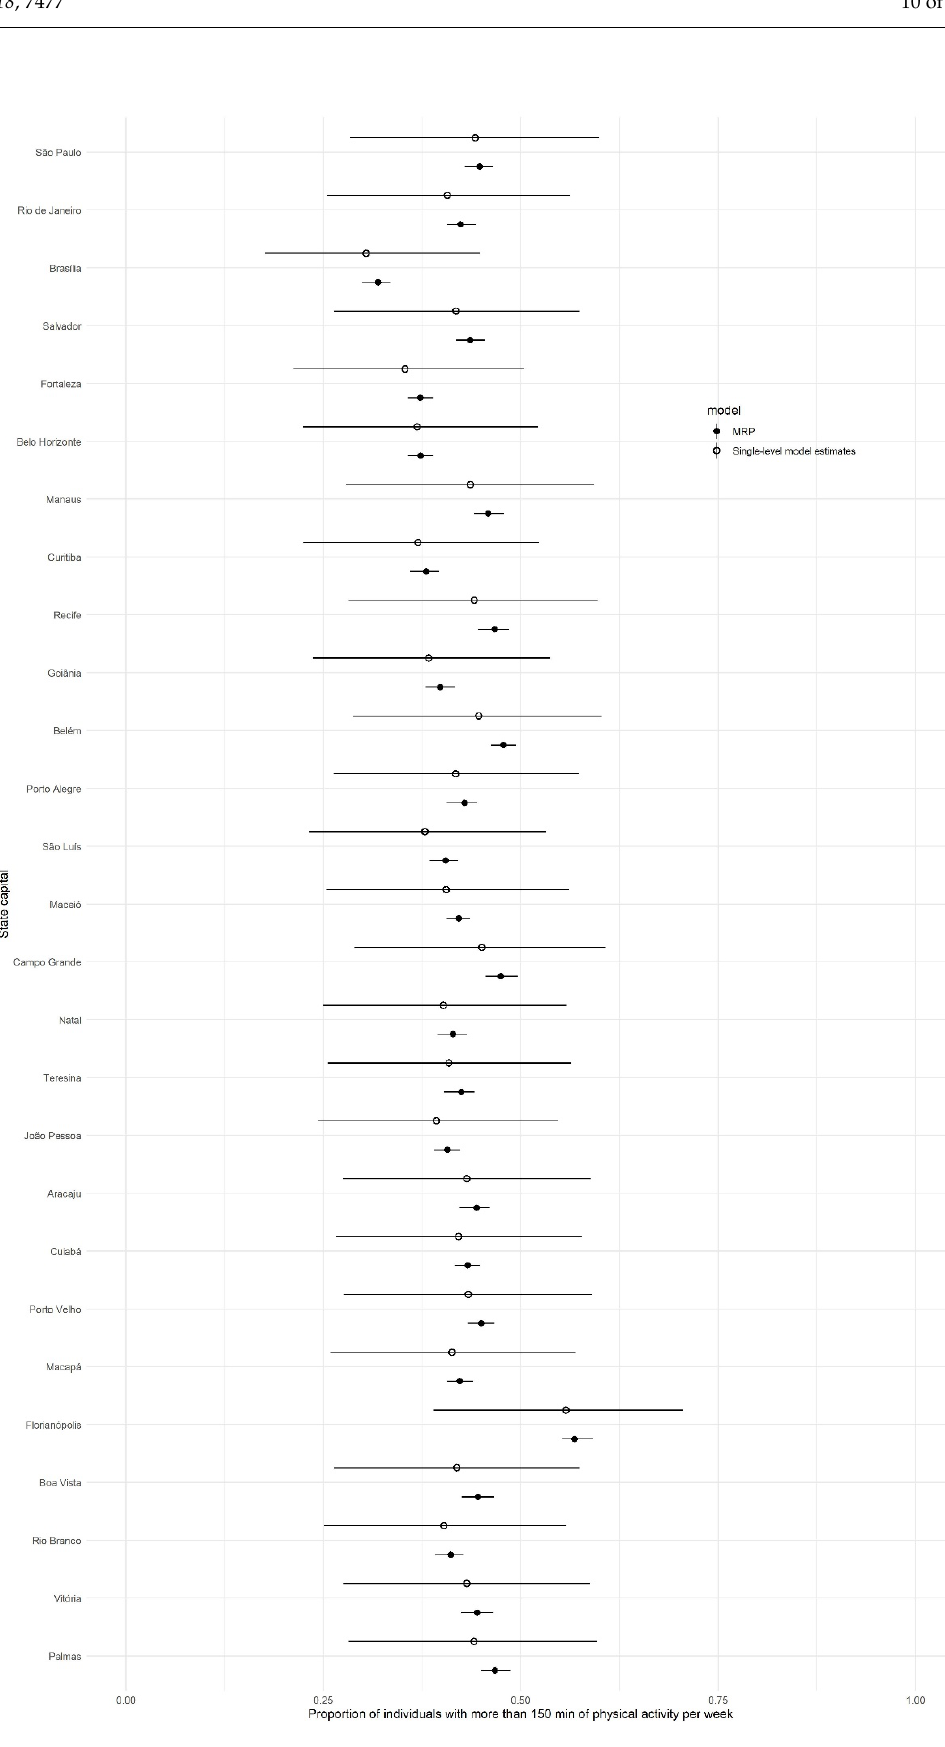
Figure 4. Estimations and 90% credible intervals of the proportion of physically active individuals by state capitals using MRP and single-level regression.